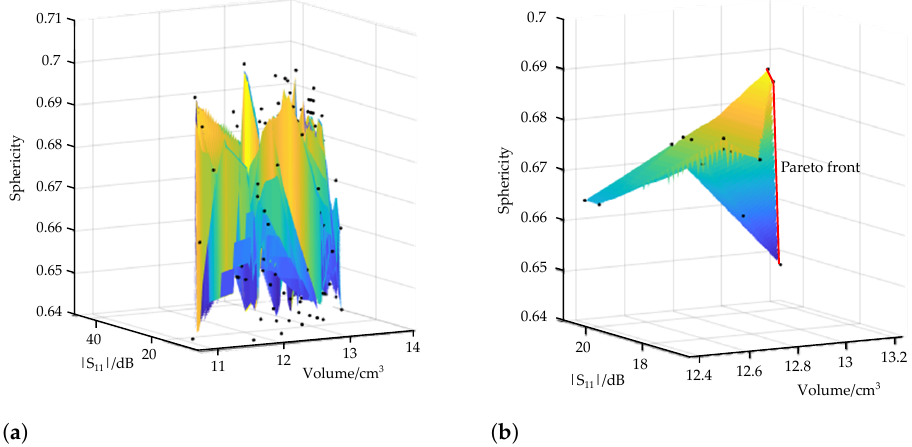
Figure 4. Three-dimensional Pareto plot of ( a ) all parametric results and ( b ) those under constraints of the sensitivity requirement of the dual-mode